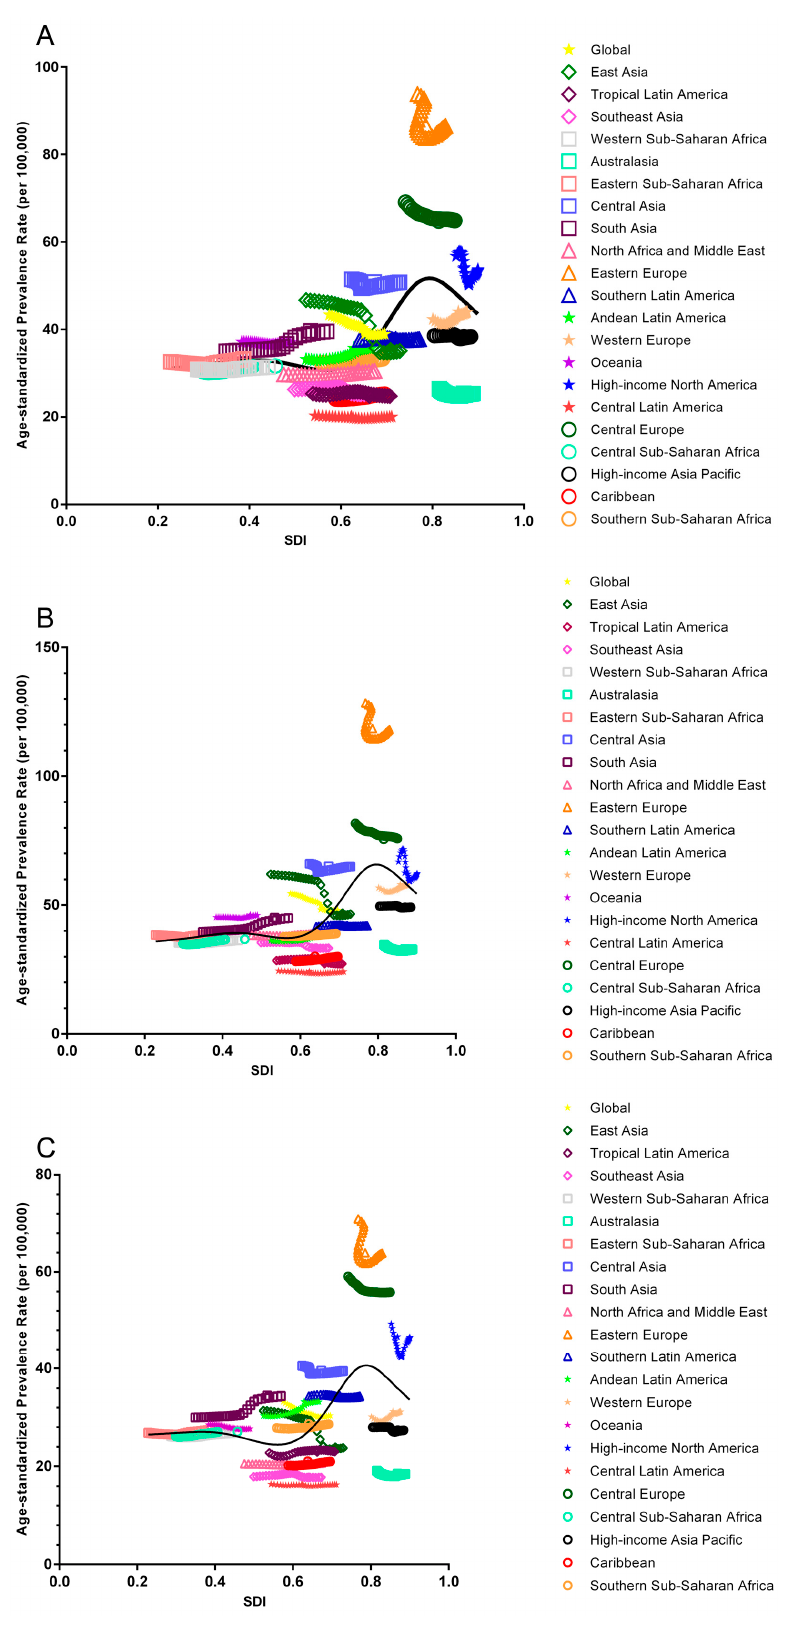
Figure 1. Annual percentage change of age standardized incidence rate of urolithiasis stratified by gender and 21 regions. ( A ) APC of ASIR stratified by SDI levels of both gender; ( B ) APC of ASIR stratified by SDI levels of male; ( C ) APC of ASIR stratified by SDI levels of